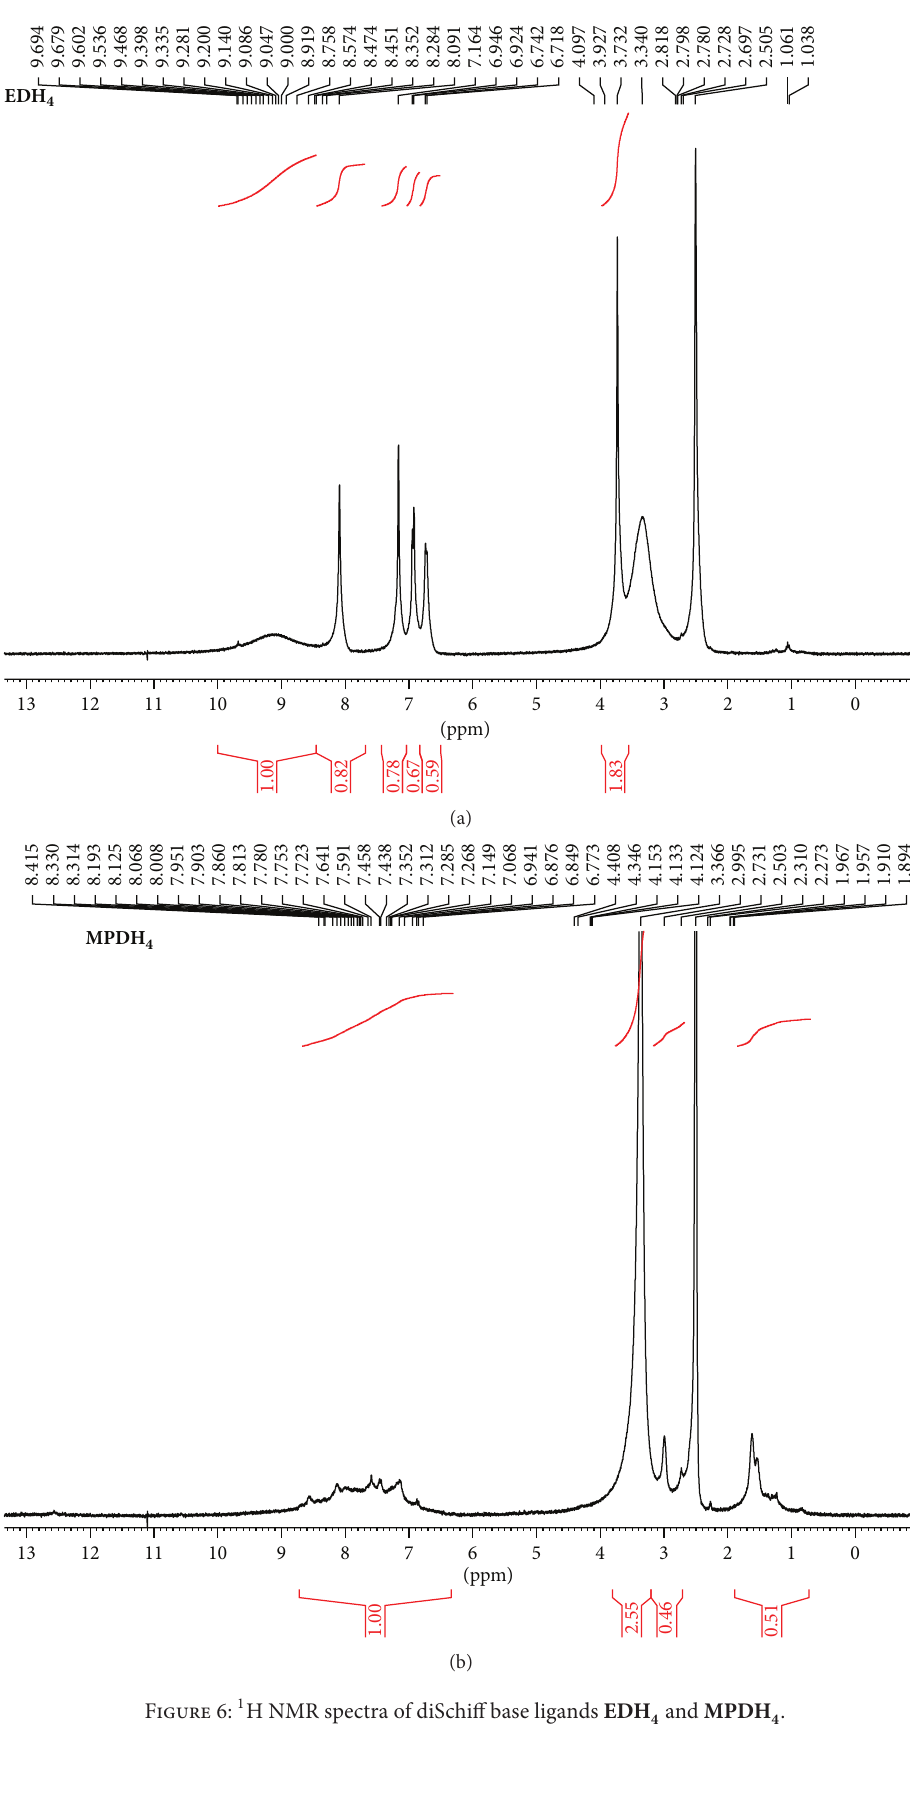
Figure 6: 1 H NMR spectra of diSchiff base ligands EDH